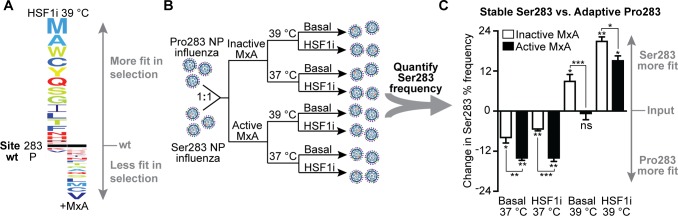
Host chaperones define the immune escape capacity of the Pro283 NP variant.(A) Deep mutational scanning reveals opposing selection forces from chaperone depletion versus MxA-mediated immune selection. Left: chaperone depletion at 39°C shown relative to the basal environment at 37°C, as in Fig 1C. Right: MxA selection from previously published deep mutational scanning data [9]. The size of the amino acid letters corresponds to the magnitude of the mutational differential selection, which is on the same scale for each selection. Amino acids above the black line are more fit than wt Pro283 in the selection condition, and amino acids below are less fit. (B) Pairwise viral competition scheme: wt NP influenza was mixed with mutant NP influenza in a 1:1 ratio. The mixture was then subjected to selection at 37°C and 39°C in both basal and chaperone-depleted (HSF1i) cells at an MOI of 0.1 virions/cell in the presence of either active or inactive MxA. (C) Change in mutant frequency upon selection is plotted on the y-axis, with the origin representing the mutant frequency in the input (inoculum). Error bars indicate the standard error from biological replicates (N = 3). The significance of deviation from input (no selection) was evaluated for each selection condition by a one-sample t test; * and ** above individual bars indicate FDR < 0.05 and < 0.01, respectively. Nested ANOVA accounting for replicates and treatment conditions was performed for all selections (p = 1.16 × 10−9). The significance of the difference in mutant frequency in the presence of active versus inactive MxA was evaluated for each selection condition by post hoc pairwise comparisons; *, **, and *** between the bars indicate p-values < 0.05, < 0.01, and < 0.001, respectively. All p-values from post hoc pairwise comparisons are provided in S9 Data. Replicate mutant frequencies are reported in S8 Data. ANOVA, analysis of variance; FDR, false discovery rate; HSF1i, condition in which heat shock factor 1 was inhibited; MOI, multiplicity of infection; MxA, Myxovirus resistance protein A; NP, nucleoprotein; ns, not significant; wt, wild type.